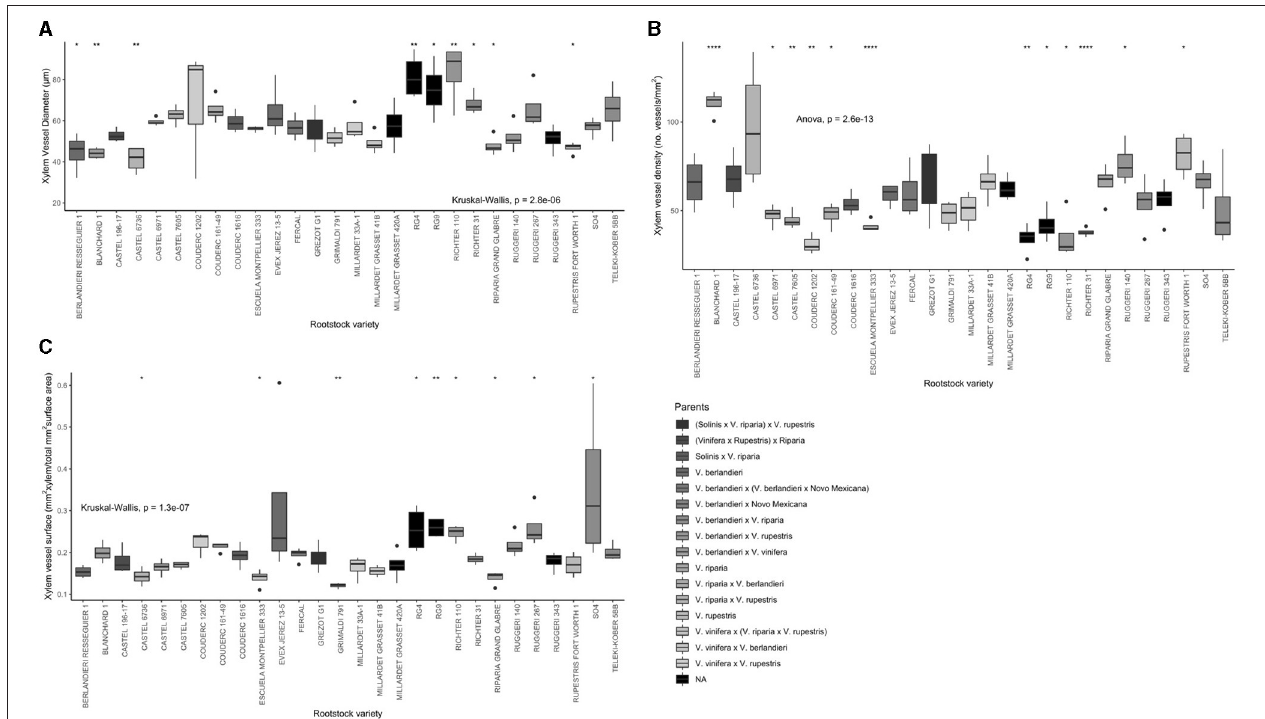
FIGURE 3 | Box plots of the histological traits for each rootstock variety. (A) Xylem vessel diameter ( µ m). (B) Xylem vessel density (number of vessels/mm 2 xylem). (C) Proportion of stem surface area covered by xylem vessels (mm 2 xylem vessels/total mm 2 vascular surface area). Significance (* P < 0.05, ** P < 0.01, and **** P < 0.0001) determined by the Wilcoxon rank sum test for (A,C) and unpaired T -test for (B) ( P < 0.05). Gray-scale color coded by rootstock parent cross (Solinis = V. longii